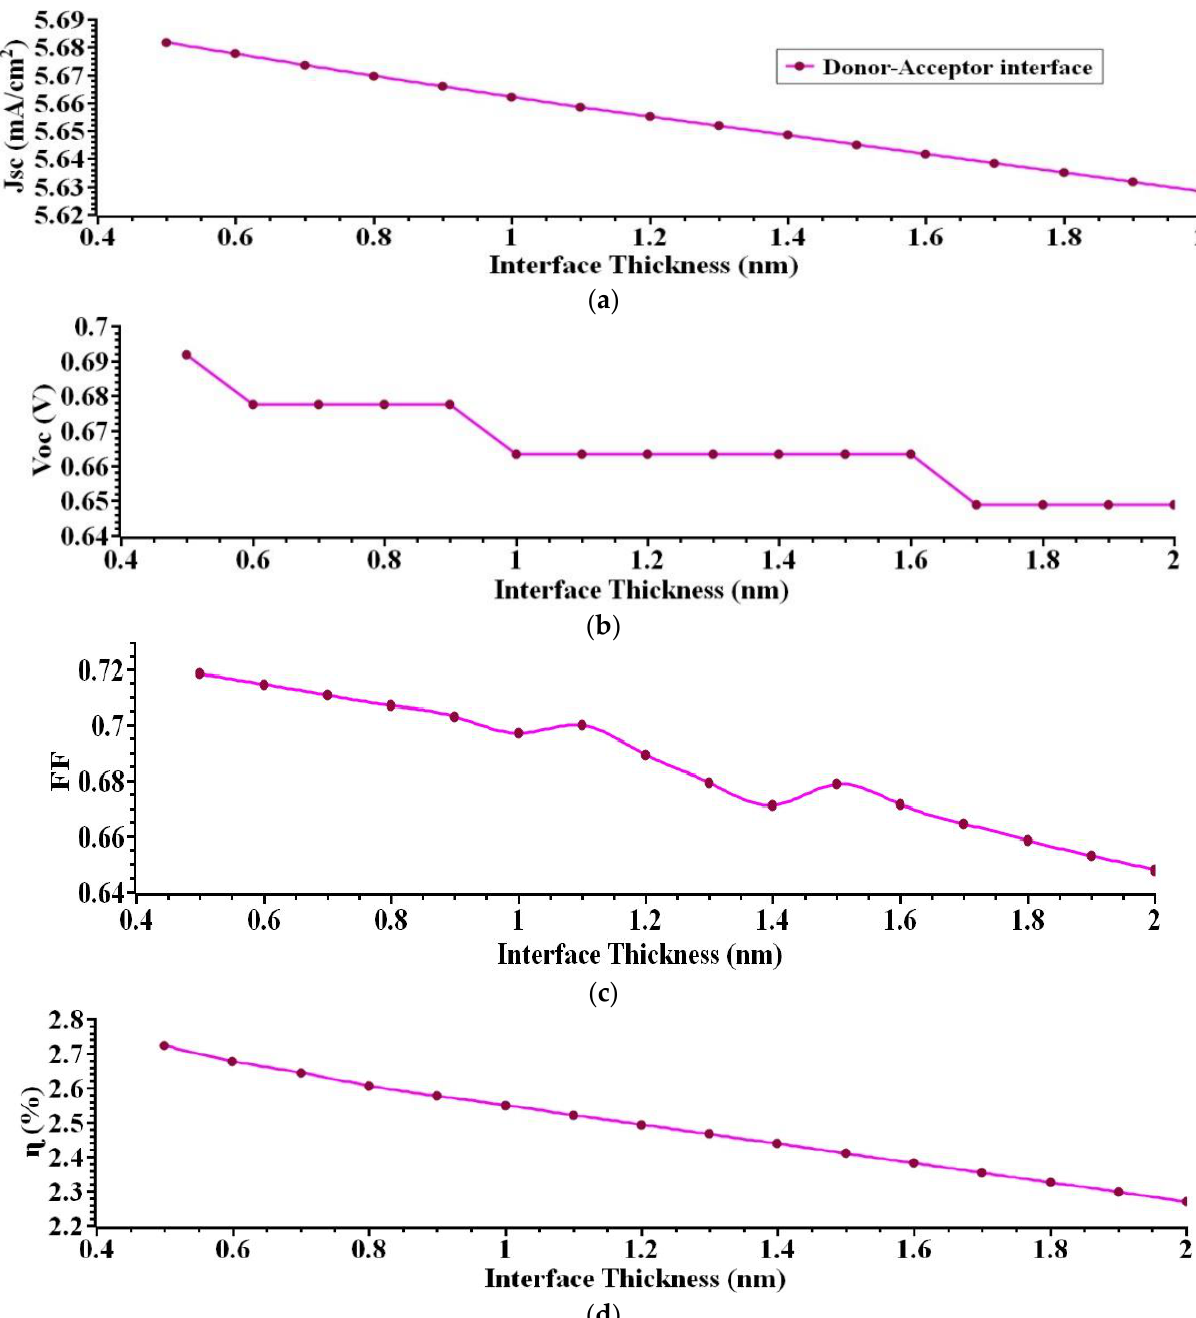
Figure 4. ( a ) J sc ( b ) V oc ( c ) FF ( d ) ɳ . Illustrates the output extracted for various interface layer thicknesses.